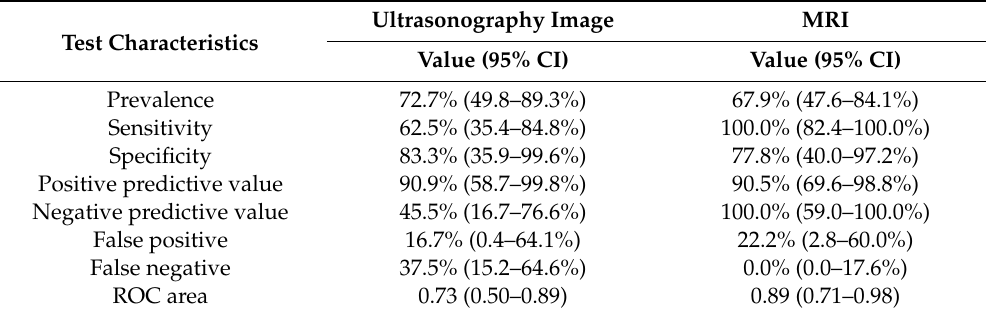
Table 2. Diagnostic analysis of ultrasonography image and MRI in maternal adnexal torsion during pregnancy.